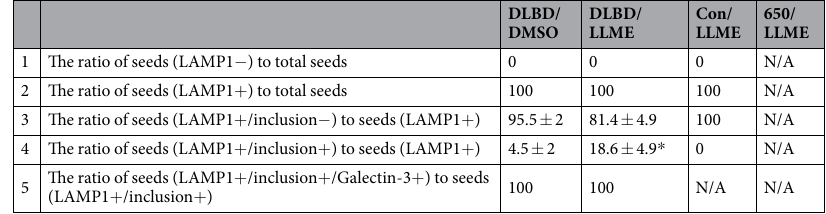
Table 2. Quantification of the ratio of the seeds associated with different structures in different groups in Fig. 9 Note: All values are percentile. * P < 0.01 versus